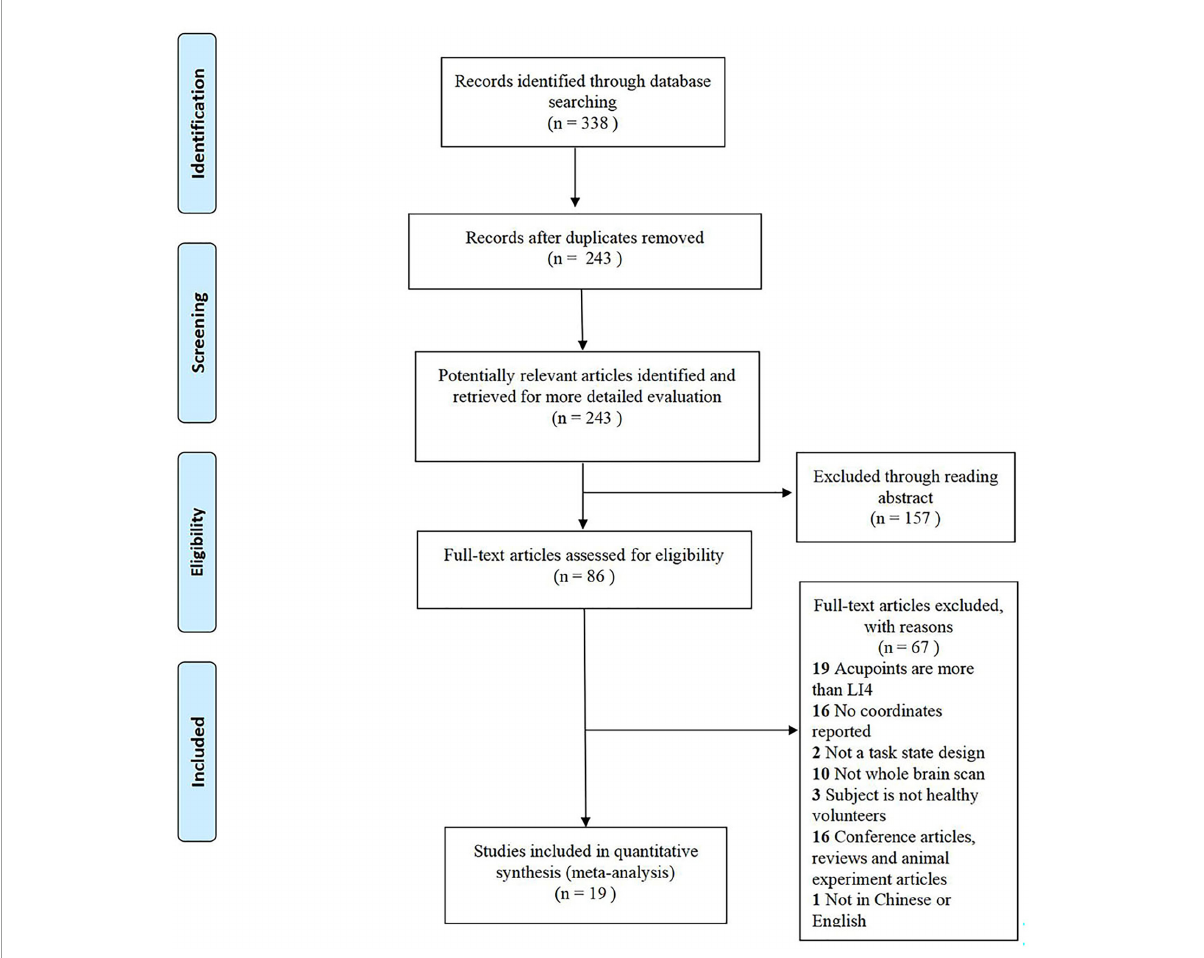
FIGURE1 The flow diagram for studies included in the present